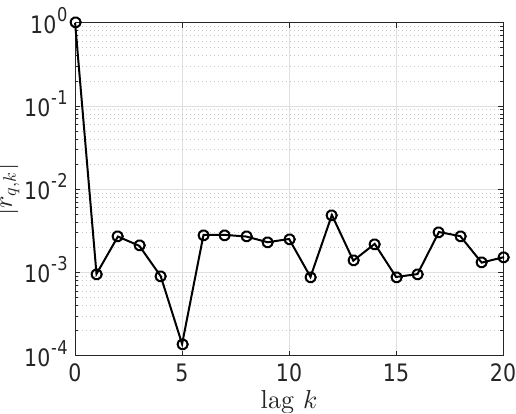
Figure 5. Absolute value of normalized correlation coefficient of complex Gauss random variables with 8-bit